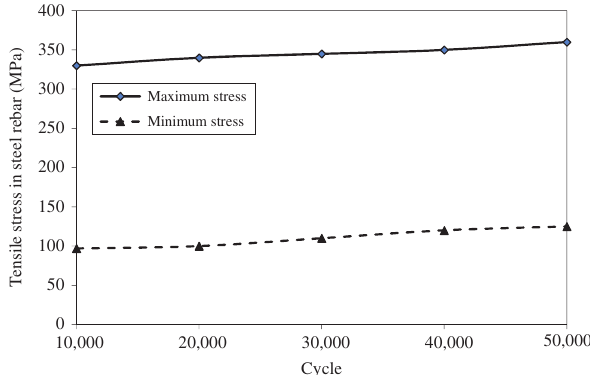
Figure 15: Variation in the longitudinal tensile stresses of steel rebars at mid-span in CFRP-retrofitted RC beams (FEM approach).